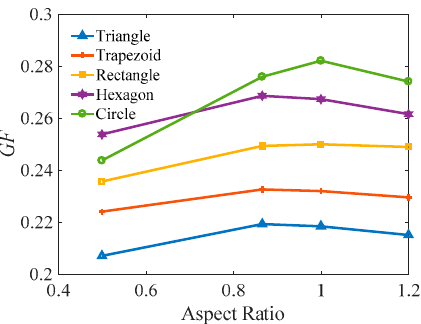
Figure 14. The geometrical factors of triangular, trapezoidal, rectangular, hexagonal, and circular cells at different aspect ratios.